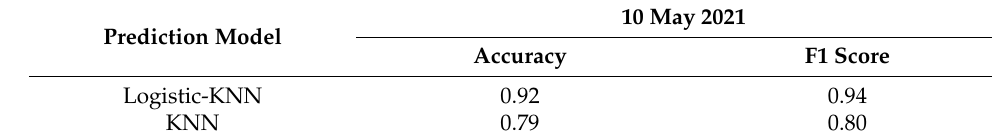
Table 5. Overall accuracies and F1 scores of the two models for 10 May 2021. Prediction Model